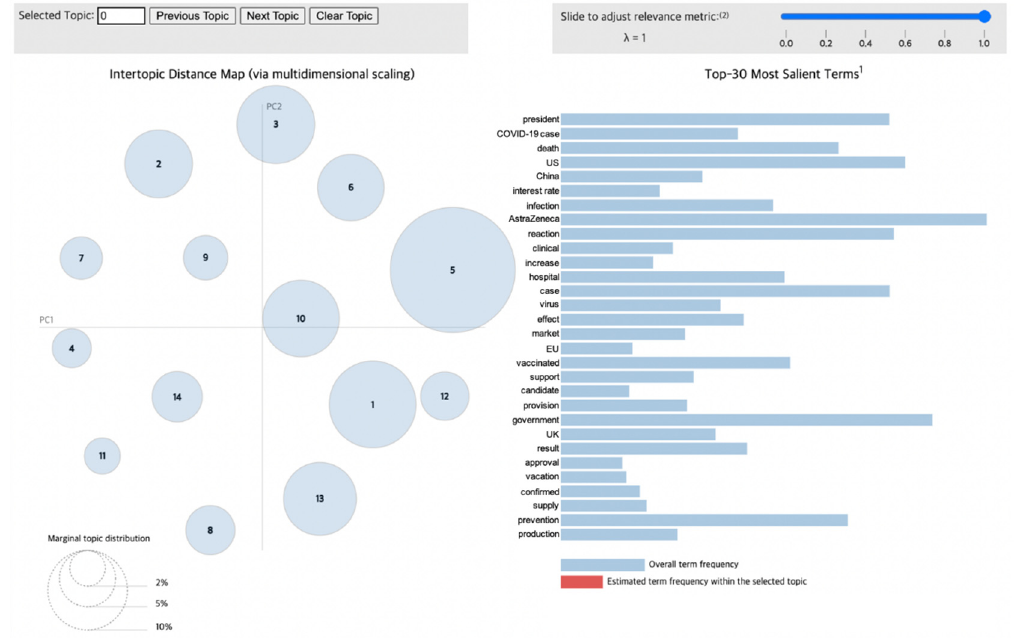
Figure 7. Topic visualization of Phase 3. Table 4. Topics drawn from Phase 3 (26 February 2021–31 March 2021).